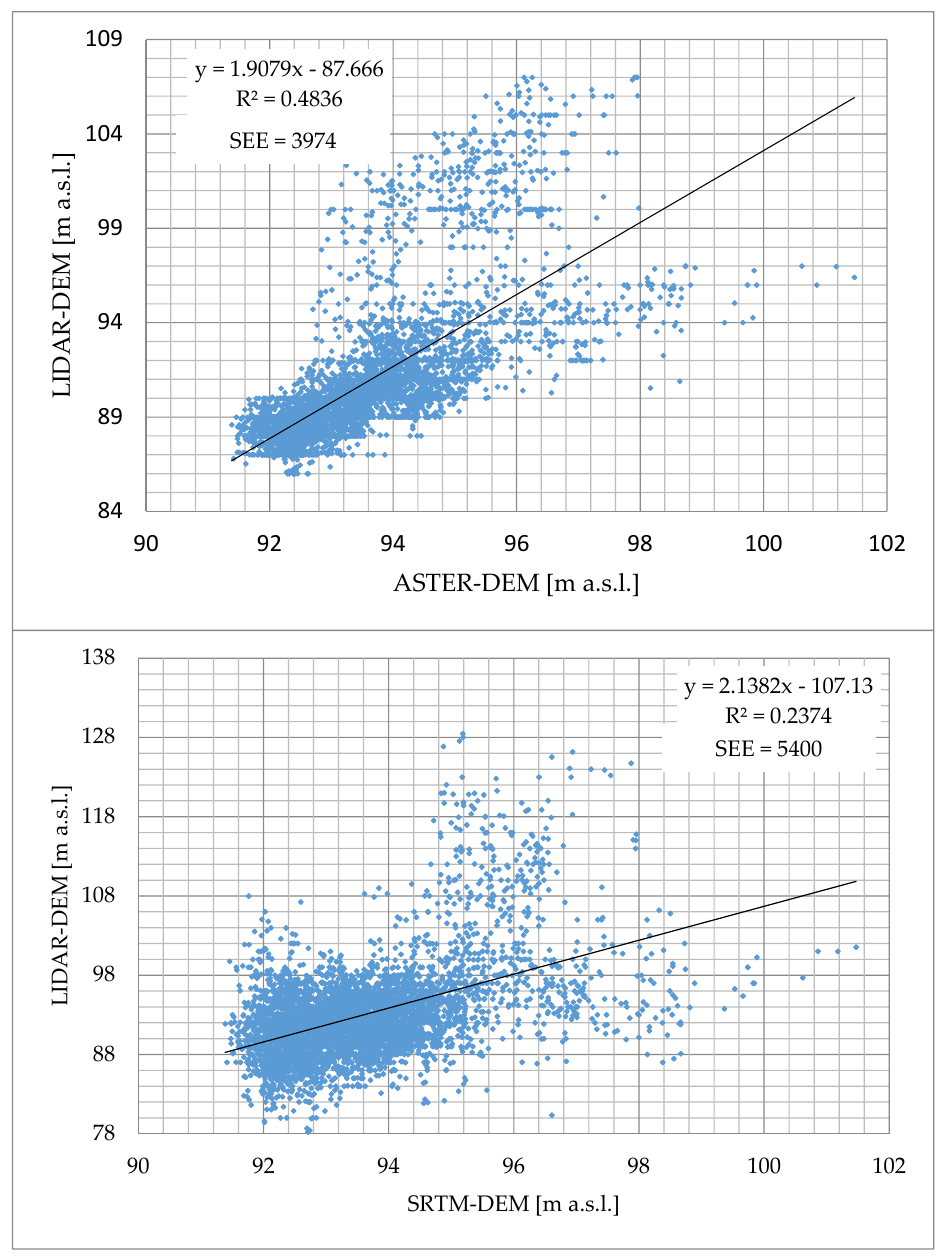
Figure 12. Comparison of the correlation between the specific models (TIN, ASTER and SRTM) and the reference model.